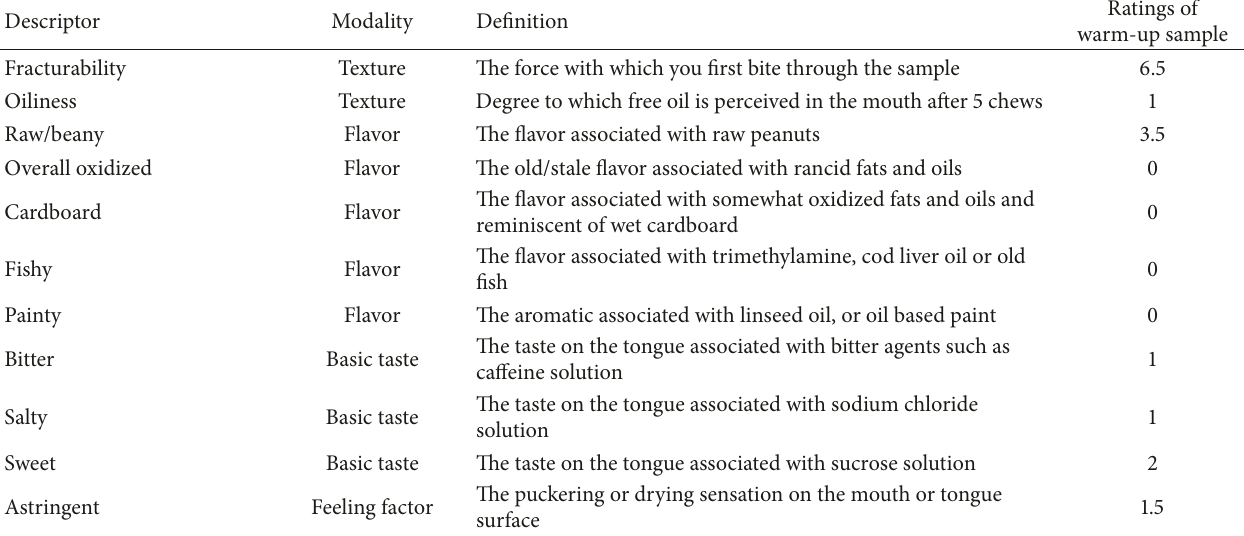
Table 2: Terms used in descriptive analysis of peanut treatments during the shelf life study.